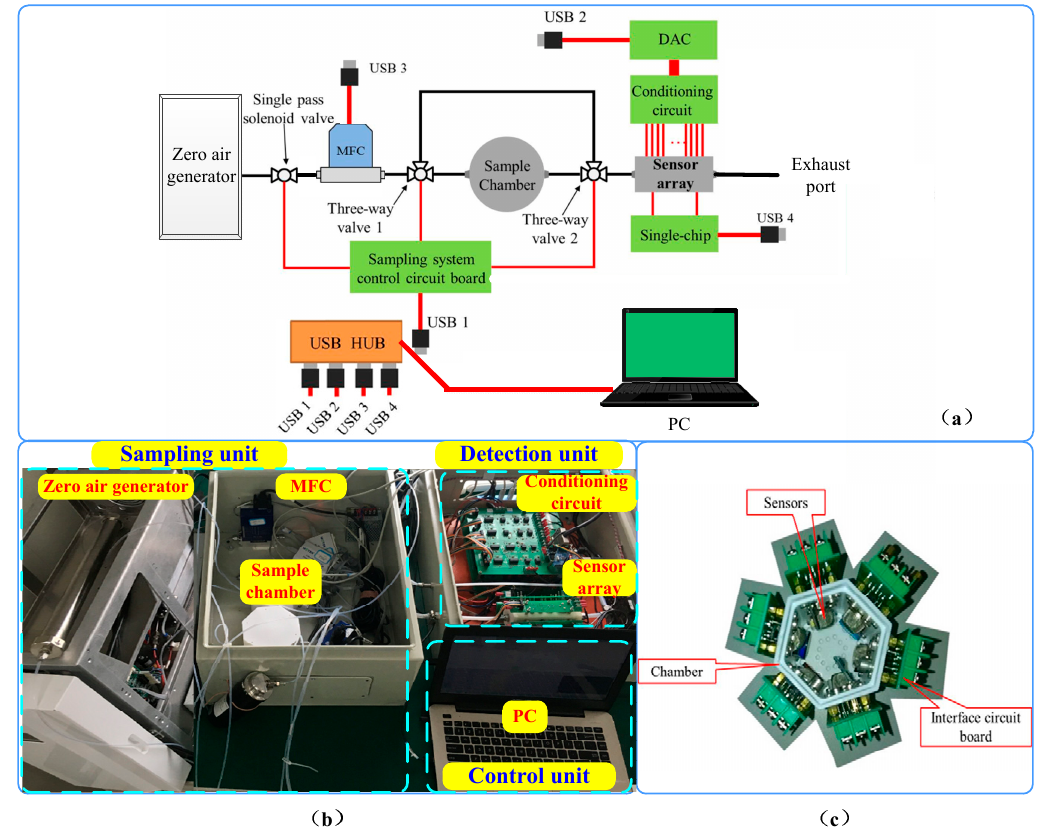
Figure 2. Schematic diagram of e-nose designed for detection of bacteria ( a ), photo of the experimental platform ( b ) and photo of the sensor chamber ( c ).